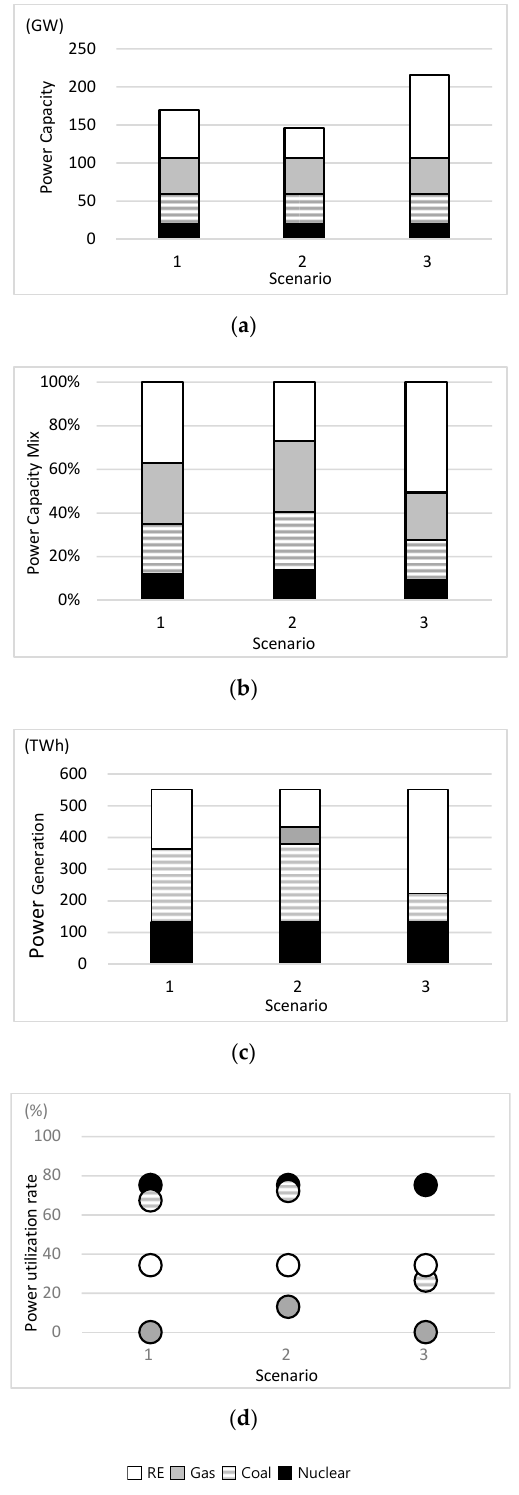
Figure 5. Electricity supply in the Korean power market. ( a ) Capacity volume; ( b ) Capacity mix. ( c ) Generation volume; ( d ) Capacity utilization.